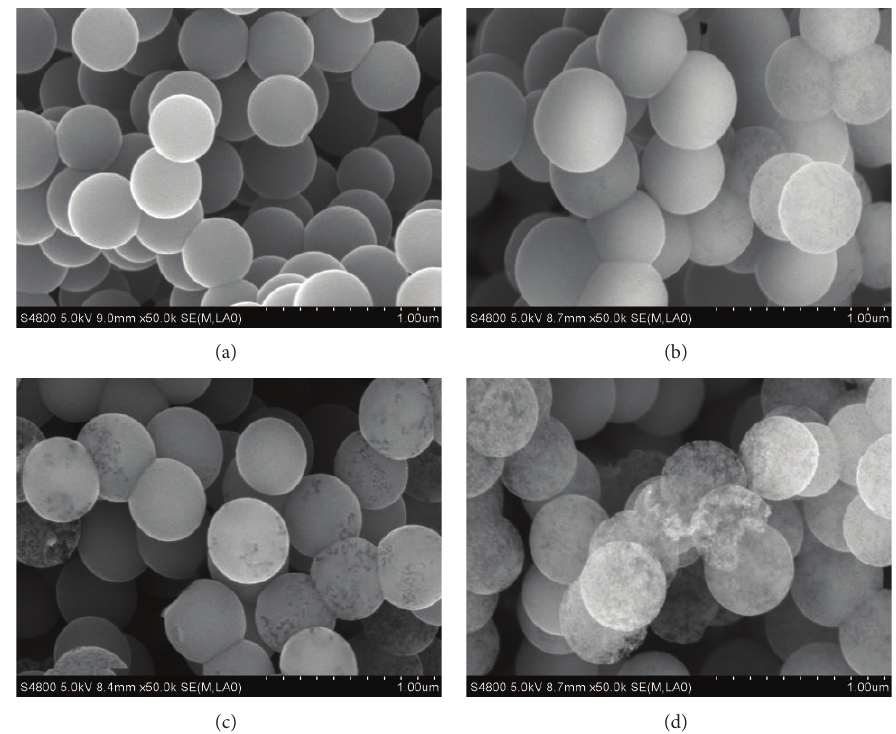
Figure 4: SEM images of the prepared samples. (a) CS0, (b) CS3, (c) CS6, and (d) CS9.